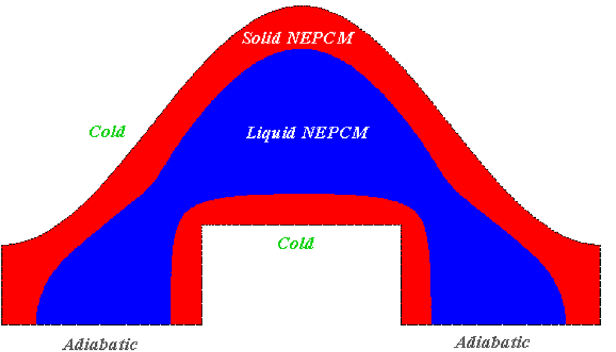
Figure 1. Freezing of water in attendance of nanoparticles through special